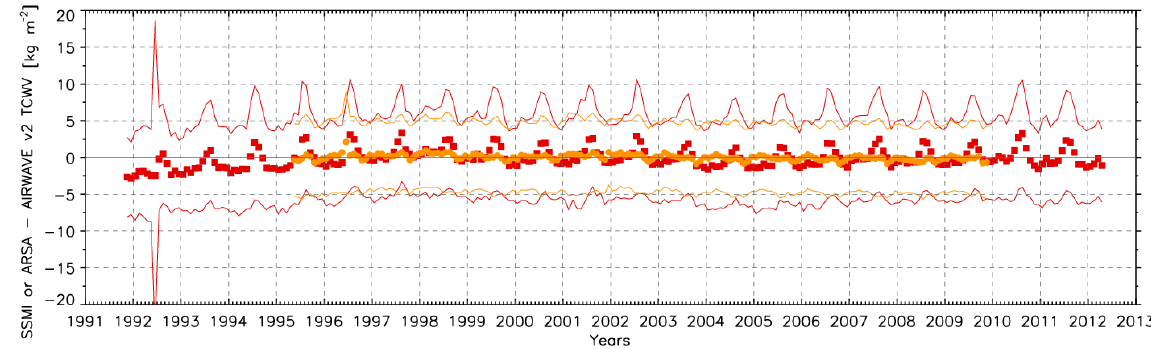
Figure 8. SSM/I-AIRWAVE TCWV (orange) and ARSA-AIRWAVE TCWV (red) monthly mean trends. The difference between the correl- ative measurements and AIRWAVE TCWV ± SD is also